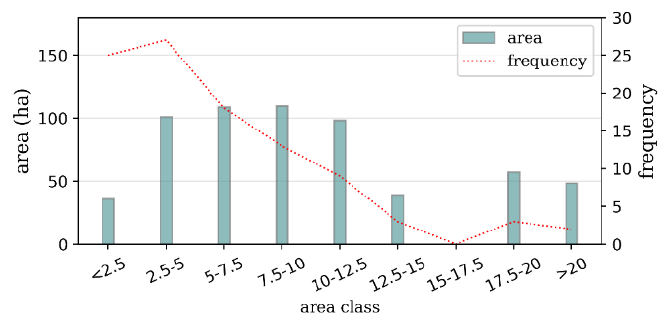
Figure 6. Time periods of the reference data used for the assessment of annual FCL. The productive forest areas of the catchment are covered by aerial imaging campaigns from different time periods. Each of the eight maps report the strata created based on the aerial image cover.